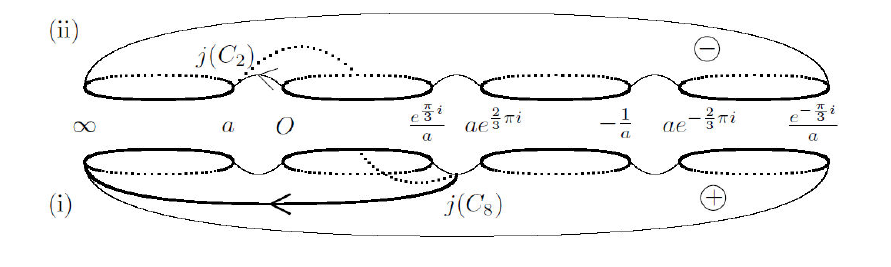
Figure A15. j ( C 2 ) , j ( C 8 ) in M